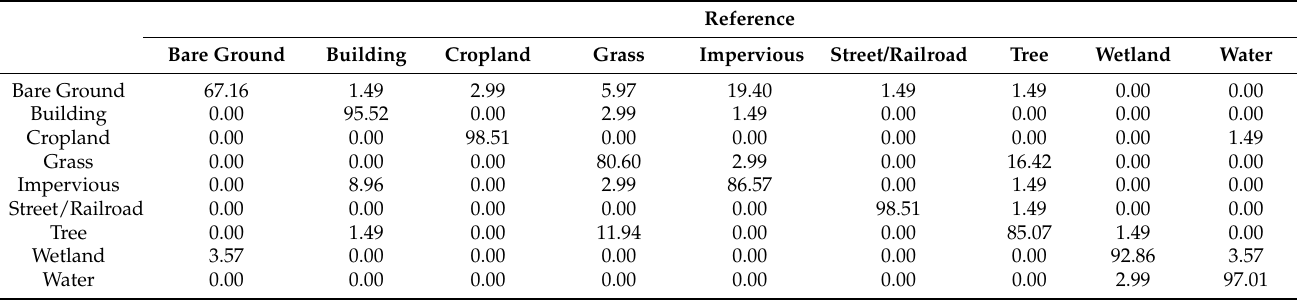
Table A1. Confusion matrix (2019). Values are percent (%) of samples classified (rows) and refer- enced (columns).